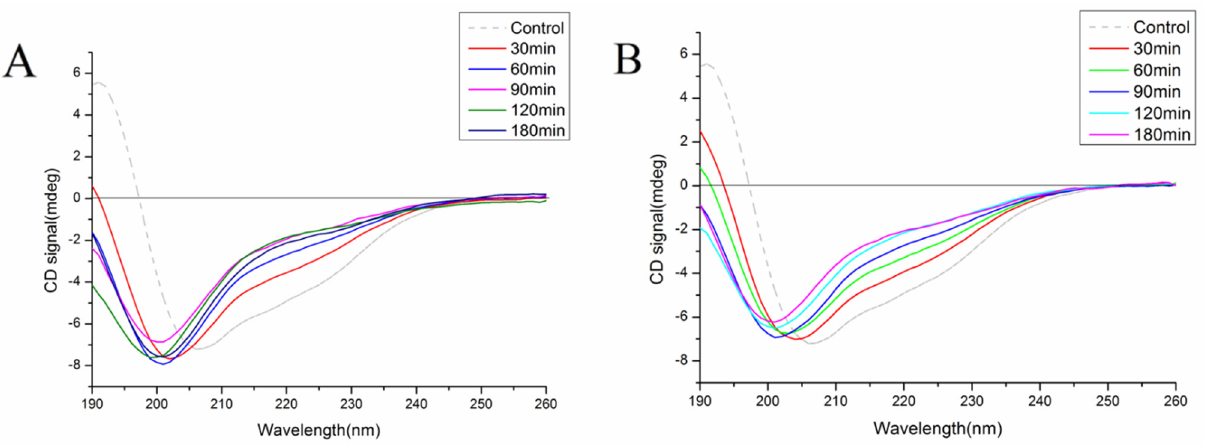
Figure 5. Circular dichroism (CD) spectra of SPI and hydrolysates prepared with ACHNs ( A ) and DCHNs ( B ). Table 1. Secondary structure content of SPI (soybean protein) and hydrolysates.